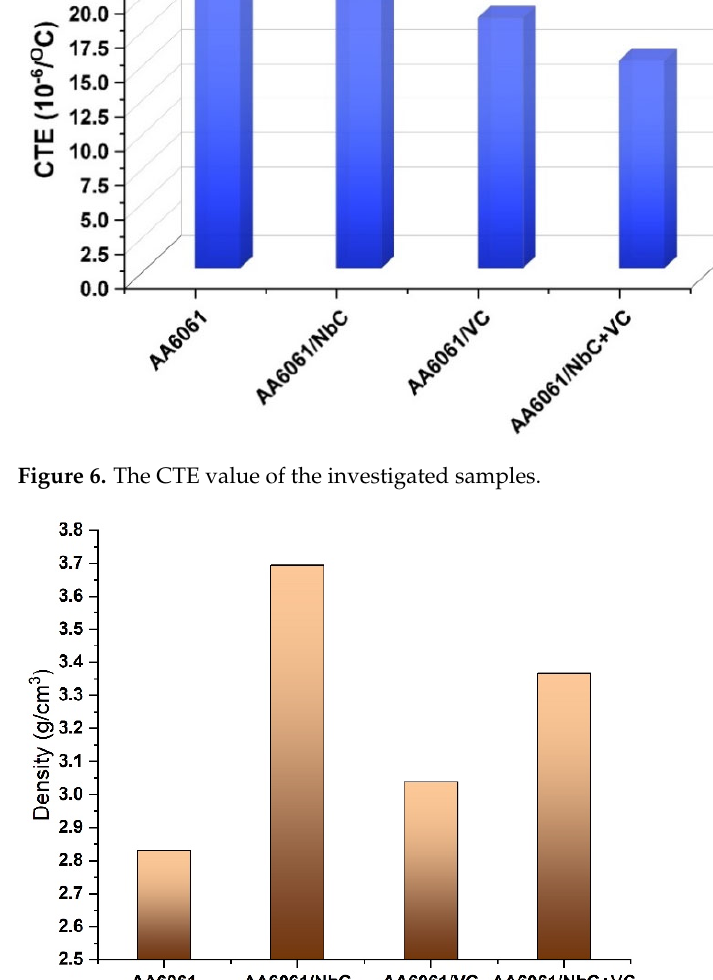
Figure 6. The CTE value of the investigated samples.